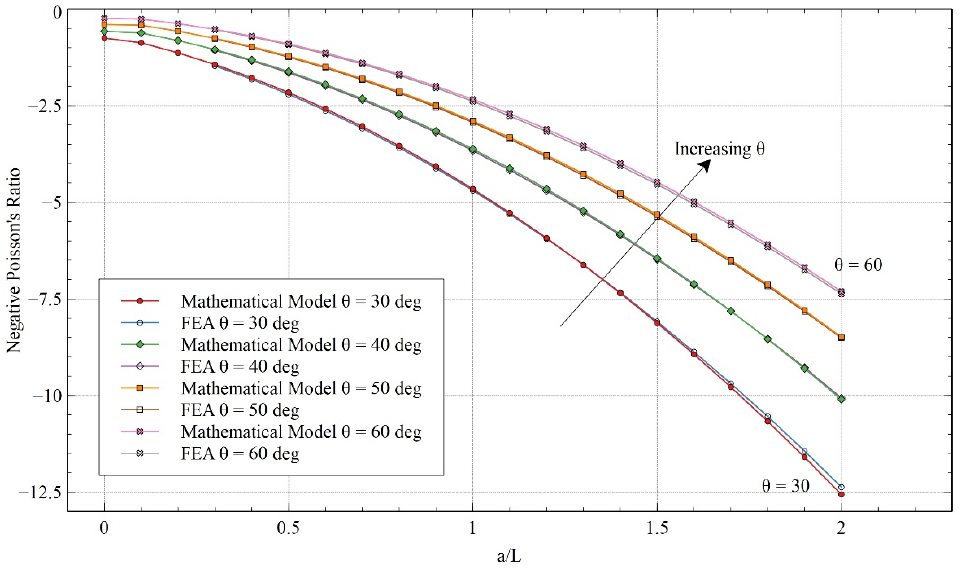
Figure 13. Poisson’s ratio obtained from the mathematical model and FEA for varying θ for x-direction loading.